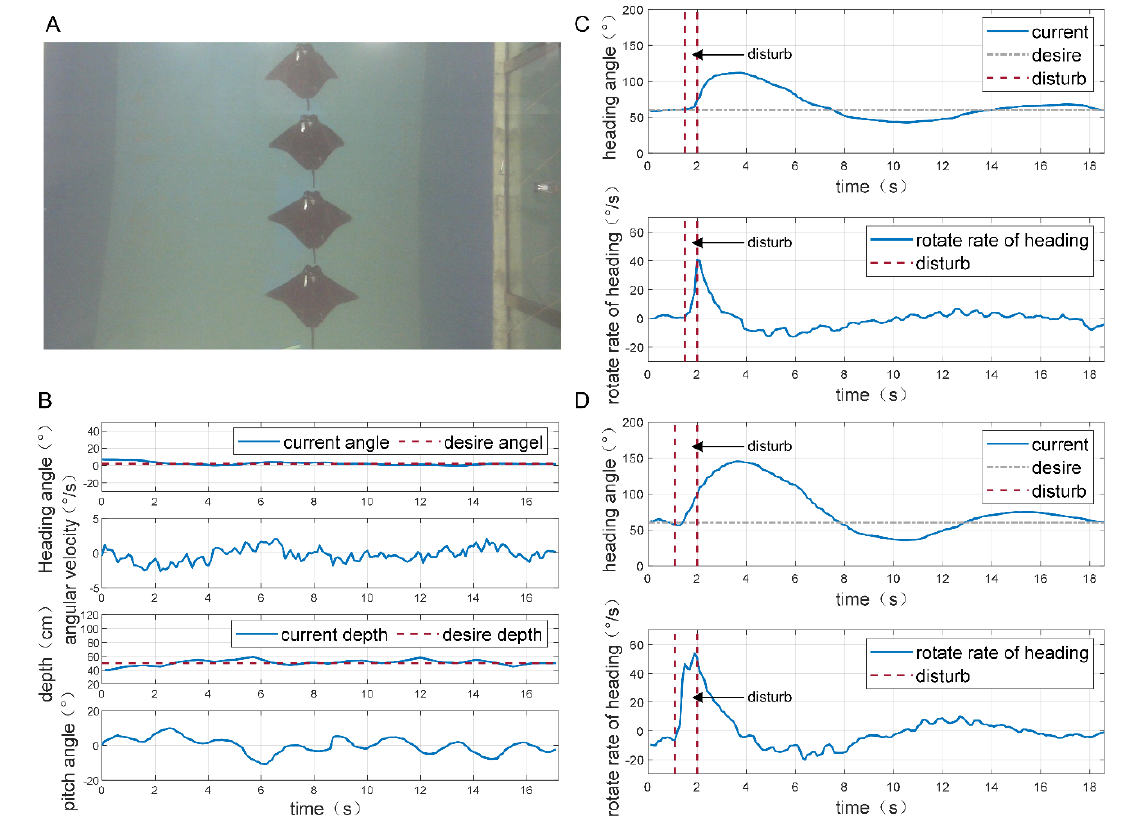
Figure 9. The picture and curves of heading tracking. ( A ) The picture of heading tracking. ( B ) The curves of heading tracking. ( C ) The curves of the first depth tracking anti ‐ interference experiment. ( D ) The curves of the second depth tracking anti ‐ interference experiment.